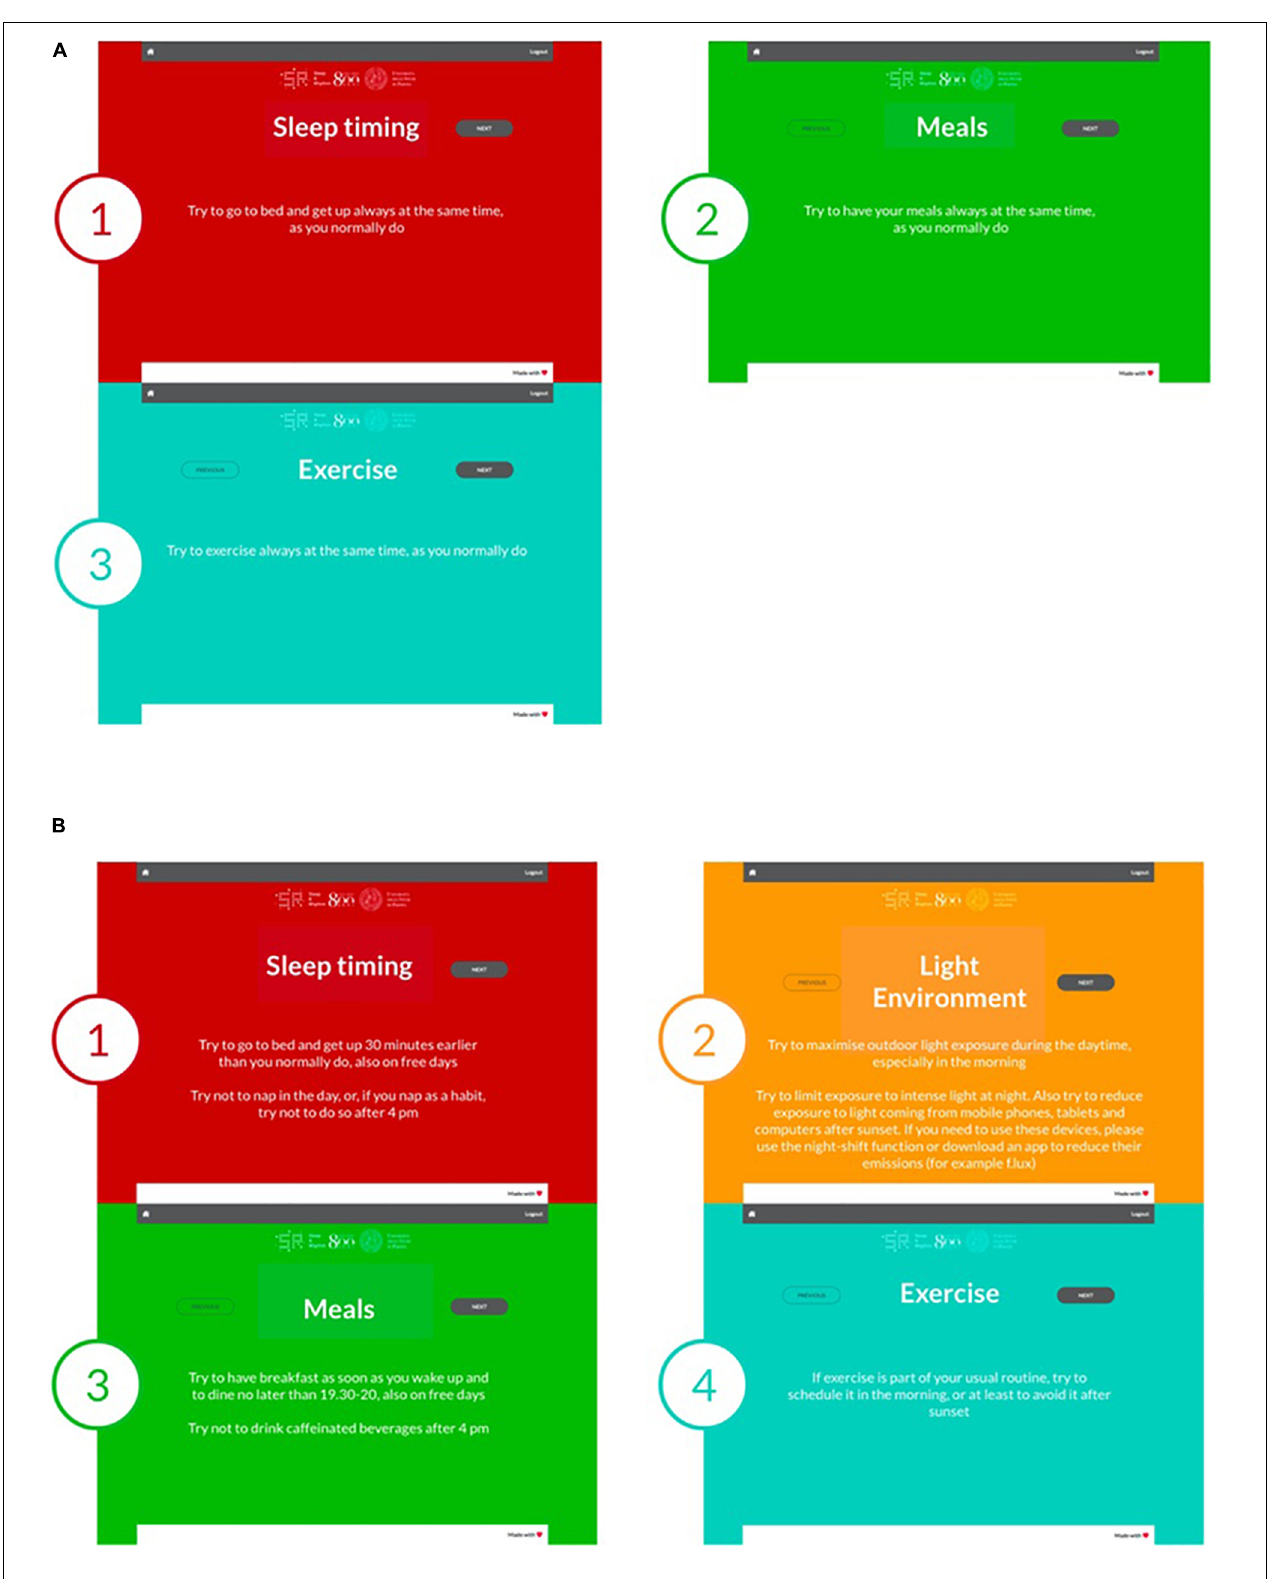
FIGURE 1 | Circadian hygiene advice. Advice provided in the “A regular life” (A) and the “Bright days and dark nights” (B) groups. The numbering of each panel refers to the temporal sequence in which the advice was provided (on subsequent smartphone/tablet/computer screens).